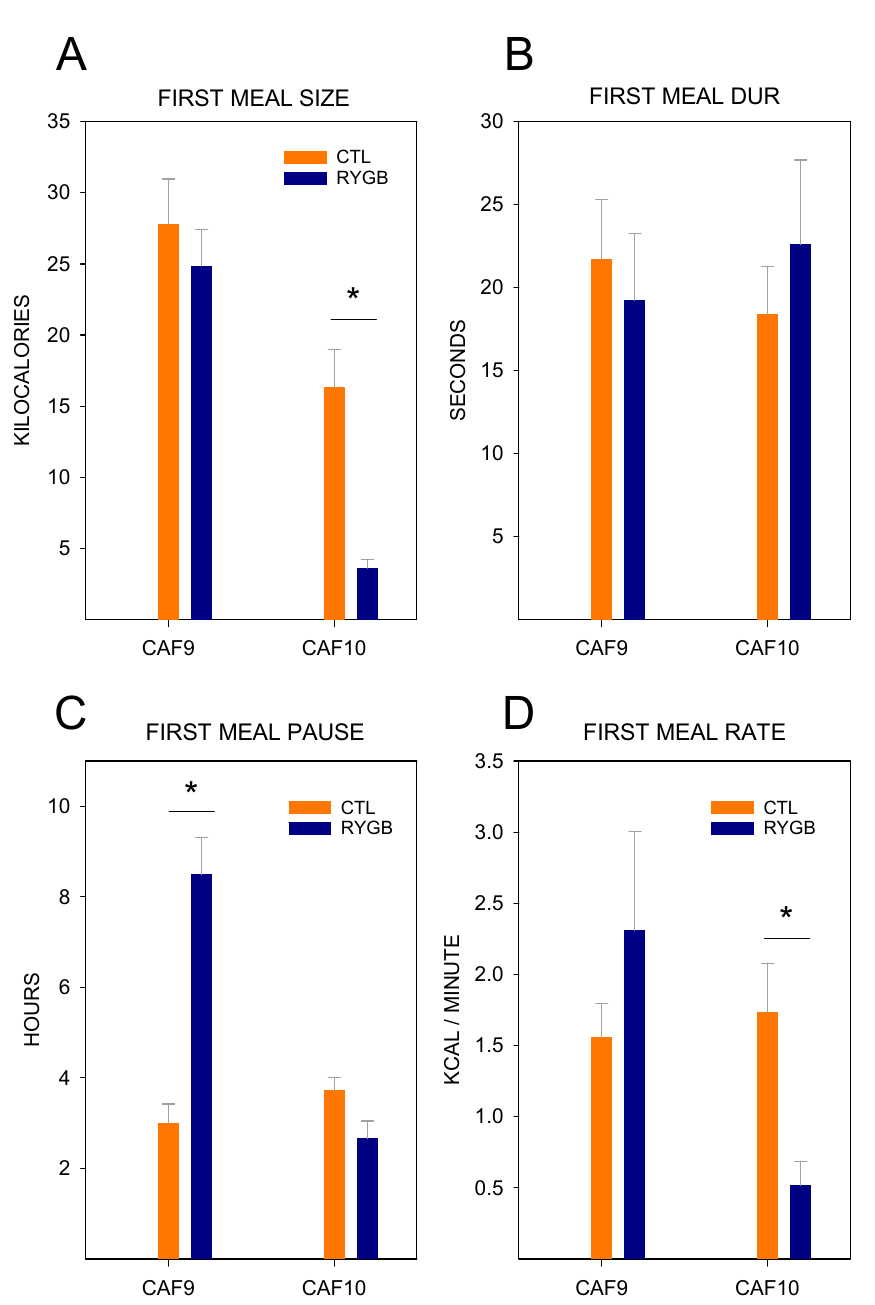
Figure 18. Meal Patterns for the First Meal Consumed on the First Day of Cafeteria Diet Exposure Postsurgically (CAF9) and the Second Day (CAF10). Mean ( ± SE) size ( A ), duration ( B ), postmeal pause ( C ) and first meal rate ( D ) for CTL (combined SHAM and IRON groups, n = 14) and RYGB ( n = 11) rats. *: Significant results ( p ≤ 0.05) from two-sample t -tests.